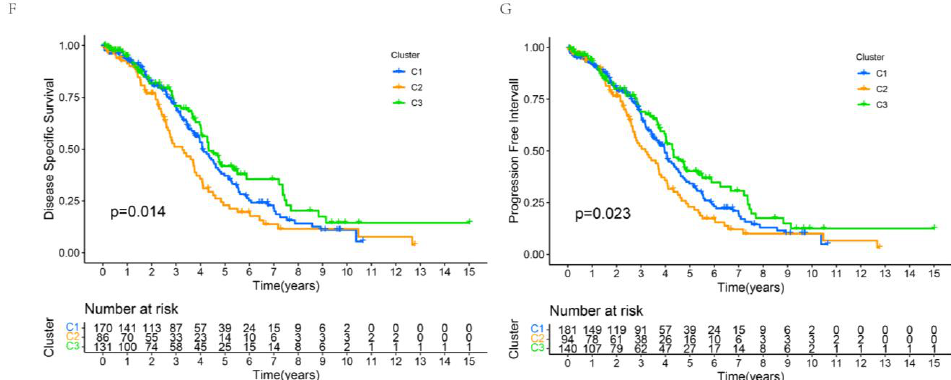
Figure 8. Identification of prognosis-related protein subgroups. ( A ) The CDF curve. ( B ) The K-means algorithm. ( C ) The consensus matrices of three prognostic-related protein subgroups. ( D ) Kaplan–Meier survival curve of prognostic-related protein subgroup overall survival (OS). ( E ) Kaplan–Meier survival curve of prognostic-related protein subgroup disease-free interval (DFI). ( F ) Kaplan-Meier survival curve of prognostic-related protein subgroup disease-specific survival (DSS). ( G ) Kaplan–Meier survival curve of prognostic-related protein subgroup progression-free interval (PFI).